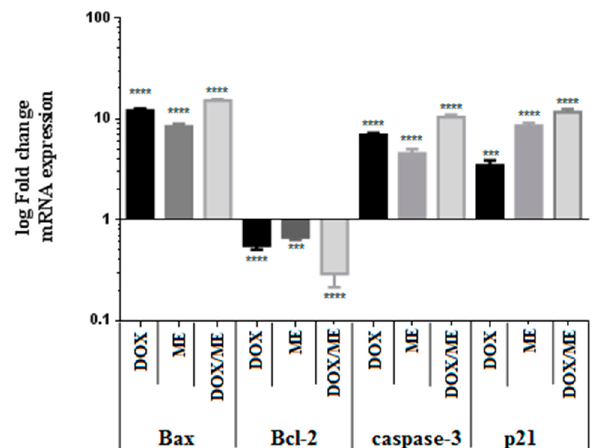
Figure 6. Histograms of the fold change in mRNA expression of Bax, Bcl-2, caspase-3, and p21 in Caco-2 cells. The mRNA levels of the apoptosis-related genes were determined corresponding to the housekeeping gene β -actin. The results were obtained from three independent experiments. *** p < 0.001, **** p < 0.0001.